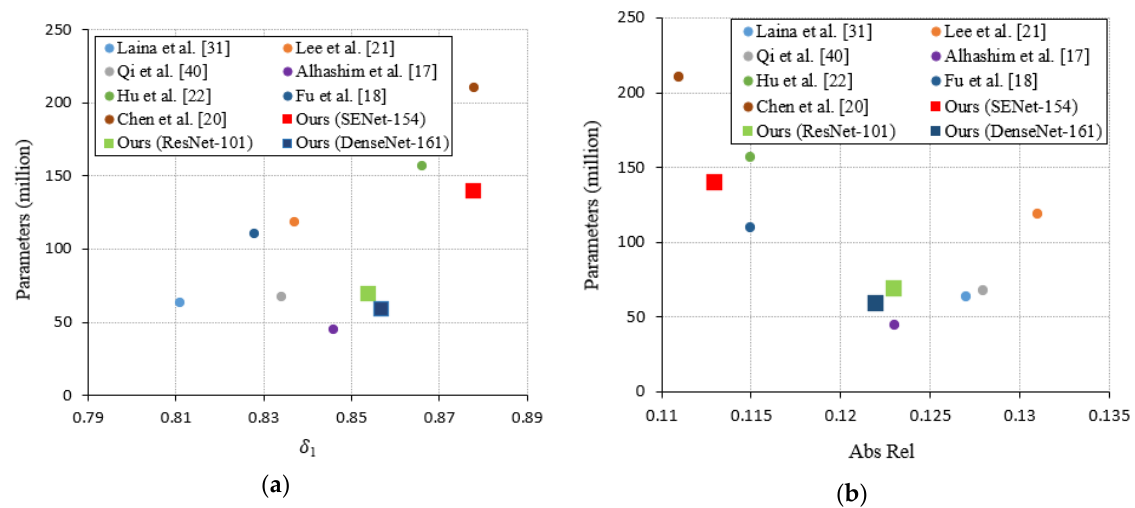
Figure 6. Model parameters and performance ( a ) with respect to δ 1 and ( b ) with respect to the absolute relative difference (Abs Rel).